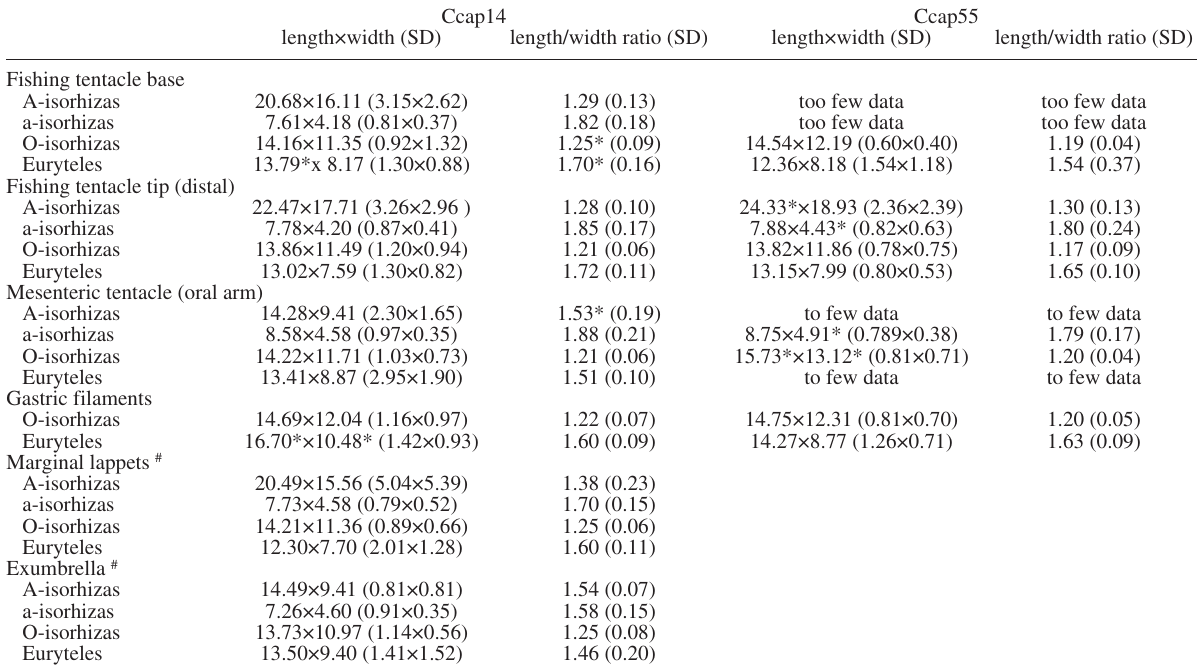
Table 1. – Size in µm of undischarged nematocysts measured in permanent tissue slide preparations of Cyanea capillata medusae. EU, Exum- brella #; FB, Fishing tentacle base; FT, Fishing tentacle tip; GF, Gastric filaments; ML, Marginal lappets #; MT, Mesenteric tentacle/oral arms.